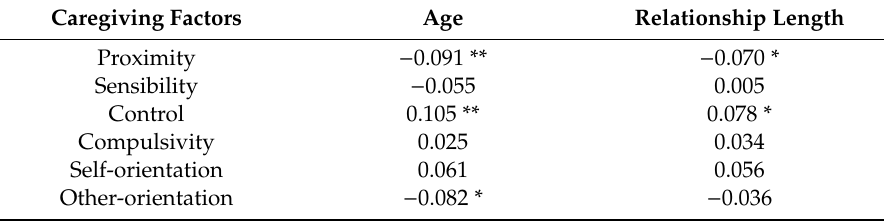
Table A3. Correlations between CQ dimensions, age and duration of couple’s